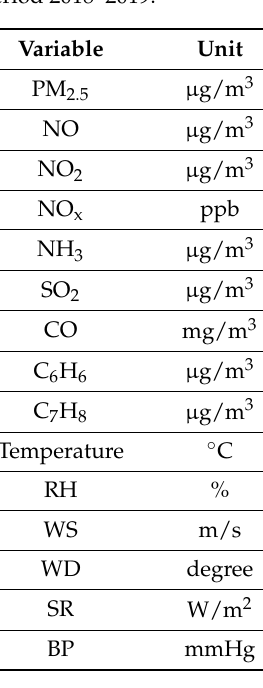
Table 1. Statistical description of air pollutants and meteorological parameters for the assessment period